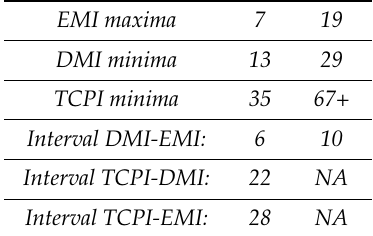
Table 12. Peaks in the EMI (Figure 12) and the corresponding valleys in the DMI followed by a dip in the TCPI.